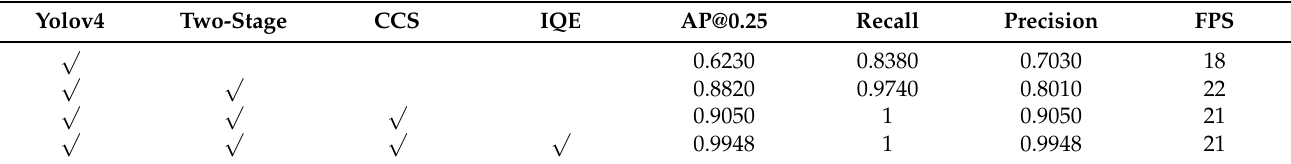
Table 1. Ablation experiment results. ‘Yolov4’ refers to Yolov4 [11] network and works as baseline; ‘Two-stage’ refers to the two-stage detection structure; ‘CCS’ and ‘IQE ’refers to CCS and IQE modules, respectively.